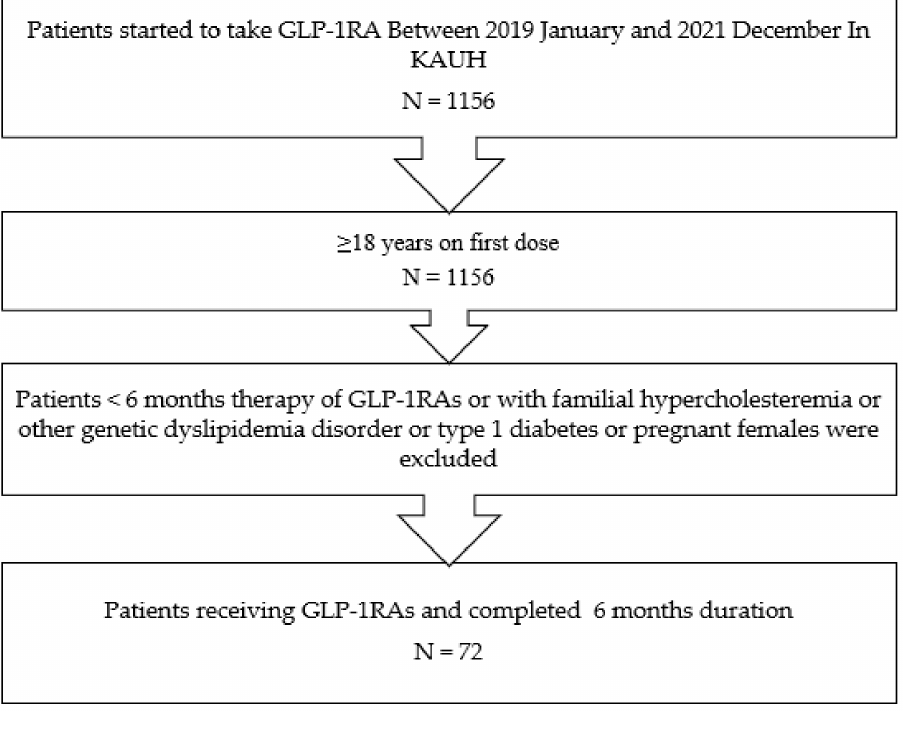
Figure 1. A flow chart presenting the sequence of data collection of patient records according to the inclusion and exclusion criteria of the study. One thousand one hundred fifty-six diabetic patients’ records were examined; patients over 18 years old who completed at least six months of GLP-1RA therapy and with clinical records from both pre- and post-GLP-1RA treatment were included in the